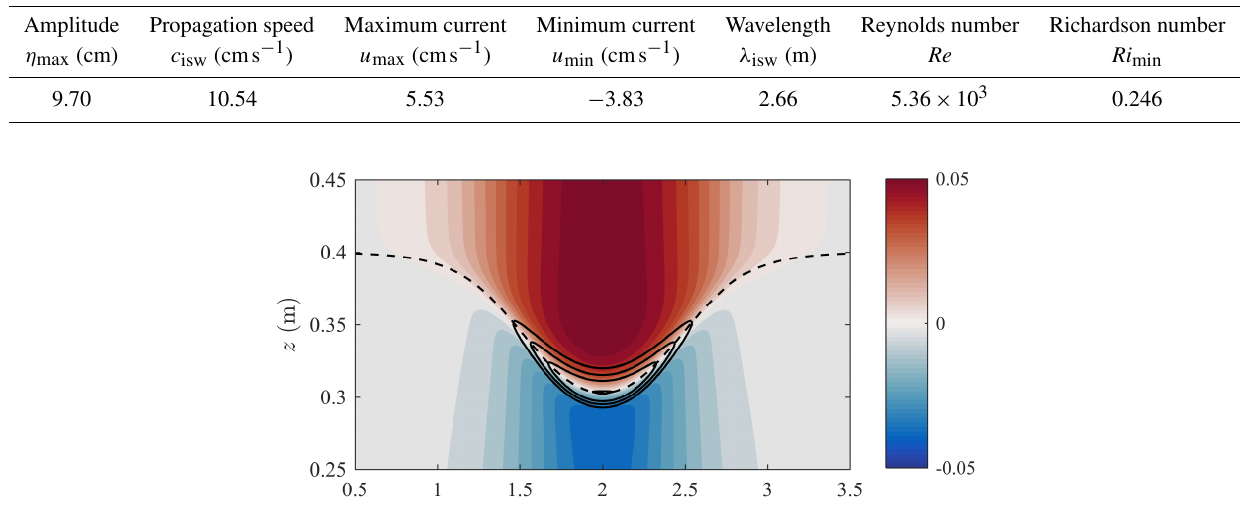
Table 1. Solitary wave parameters. Here, the amplitude is measured by the maximum isopycnal displacement η max , and the wavelength is measured by the horizontal velocity profile along the inviscid upper boundary according to the formula λ isw = 2 (x R − x L ), where x R and x L satisfy the equation u(x R ,L z ) = u(x L ,L z ) = 0 . 5 u max .